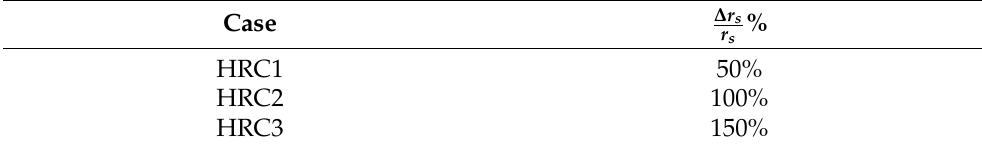
Table 3. Severity levels of HRC